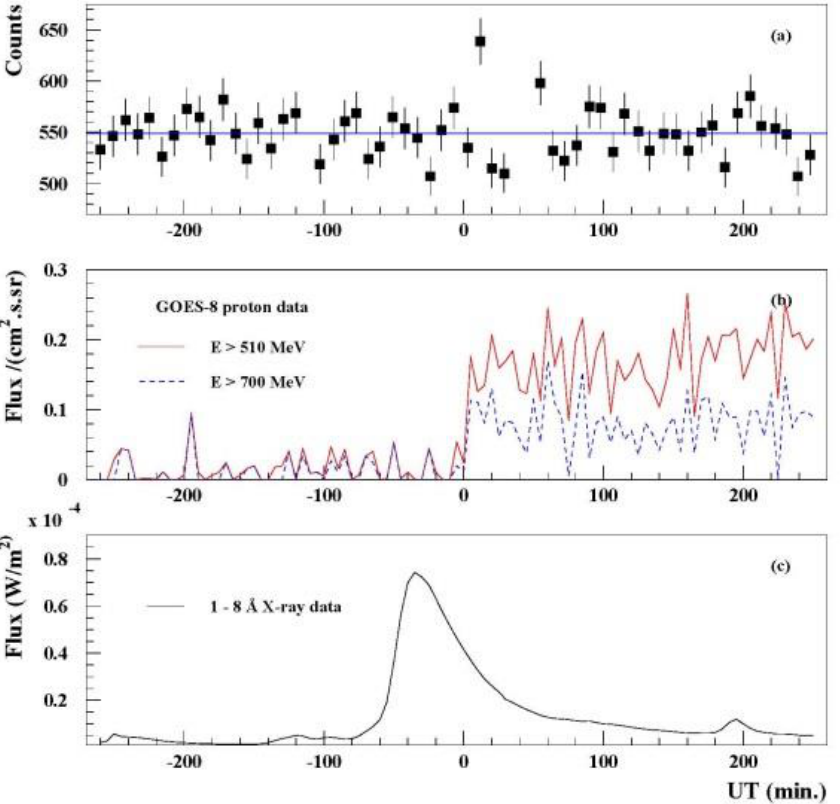
Figure 4. ( a ) Number of events versus time in minutes for 6 h (around the zero of the horizontal axis at 24:00 UT on 8 November 2000) in sky cell No. 48. The live-time bin width is 8.39 min. The blue solid line shows the mean value of the background. ( b ) Time profiles of proton fluxes registered by GOES-8. The red solid line corresponds to proton energies higher than 510 MeV and the blue–dashed line to energies above 700 MeV. ( c ) Time profile of 1–8 Å soft X-ray registered by GOES-8.